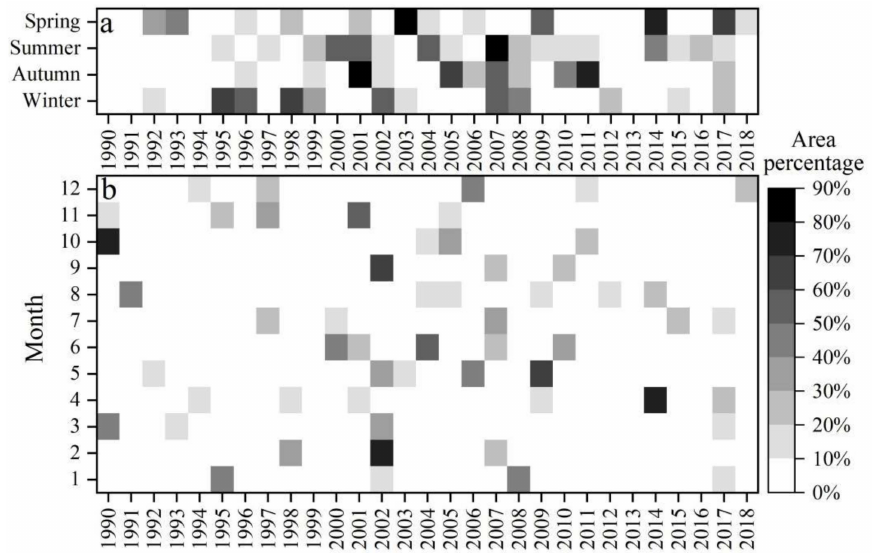
Figure 4. Percentage of monthly light and quarterly moderate drought area SPEI03 < − 1, ( a ); SPEI01 < − 1.5, ( b ) in northeast China (NEC) from 1990 to 2018.